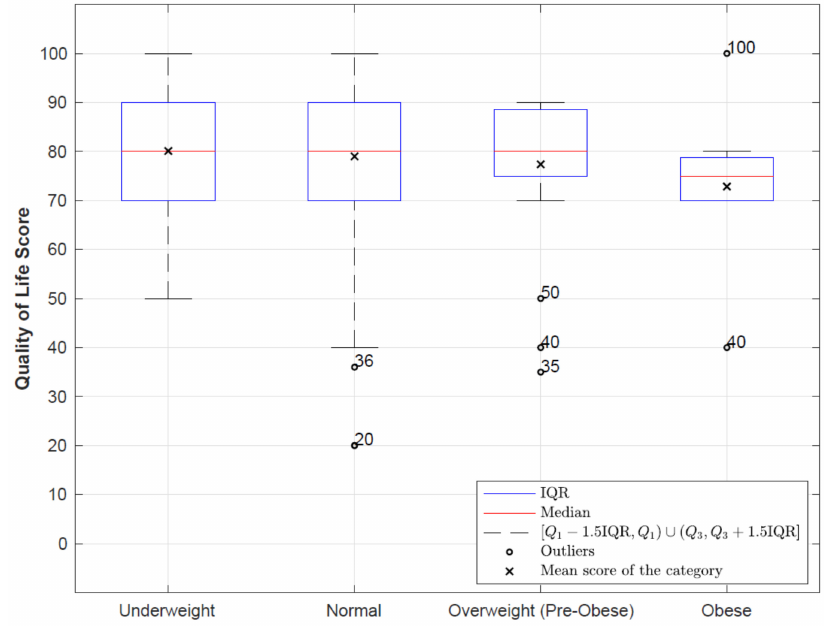
Figure 1. Comparison of mean scores on the perception of quality of life using EuroQol5-D among women with and without